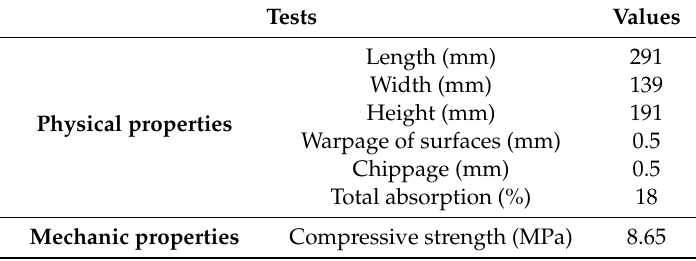
Table 3. Characterization of clay tiles according to ASTM C-652